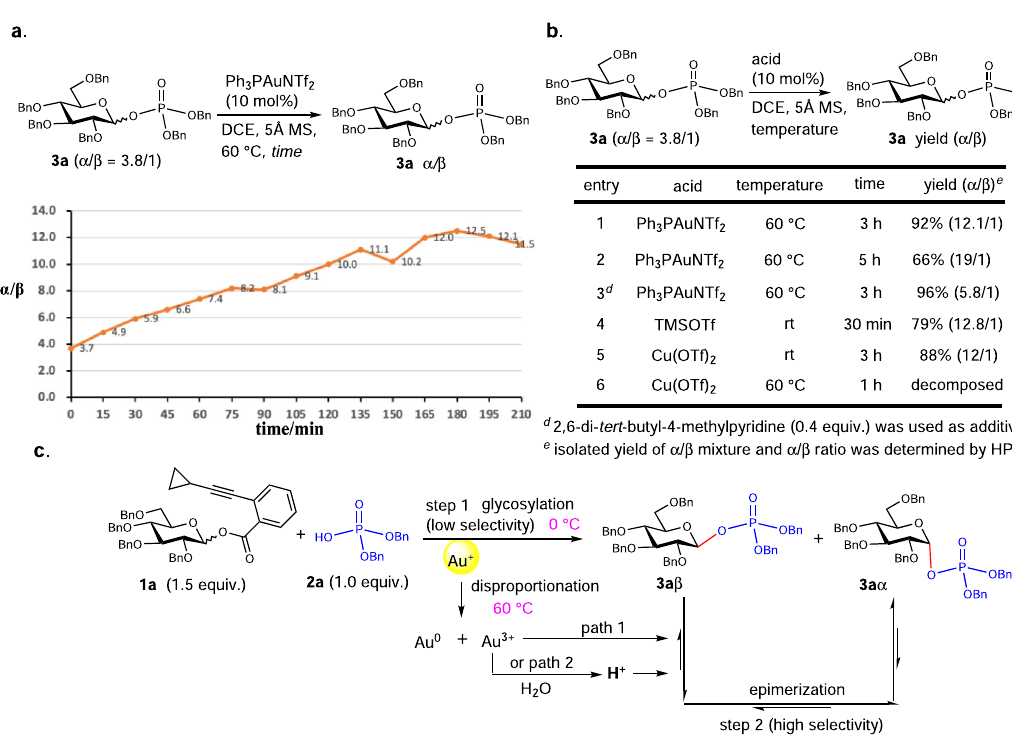
Fig. 9 Mechanistic studies. a The plot of α / β ratio versus reaction time. b The epimerization reaction with various acids. c The proposed mechanism. In red are the formed glycosidic bonds. In blue are the phosphoric acid and the phosphate moiety in product. In pink are the reaction temperatures. In yellow is the gold(I) catalysis. In orange is the curve of α / β ratio versus reaction